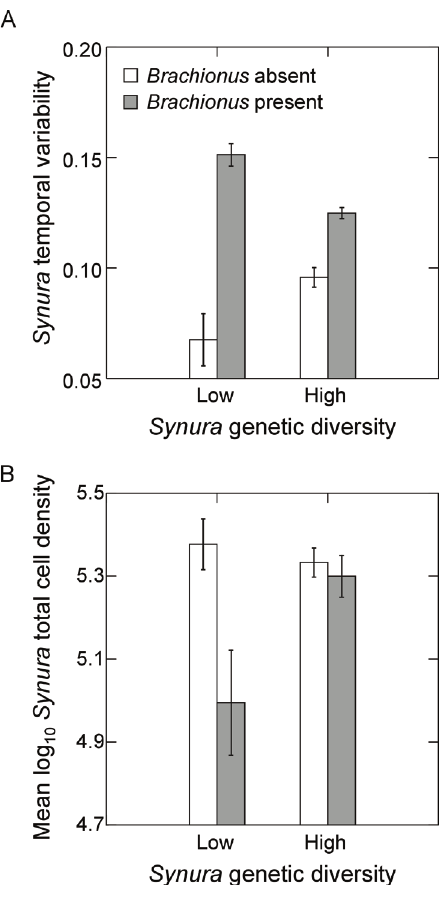
Figure 5. Effects of initial Synura genetic diversity (low versus Figure 6. Effects of initial Synura genetic diversity (low versus high) and Brachionus presence/absence on ( A ) detrended temporal high) and Brachionus presence/absence ( A ) detrended temporal variability of Synura populations (based on total cell densities), variability of free-living cells of Synura , measured as mean residuals measured as mean residuals from linear regressions of log from linear regressions of log transformed free cell densities versus transformed Synura density versus time, and ( B ) Synura total cell time, and ( B ) detrended temporal variability of colony cells of densities averaged over the course of the experiment. Both measures Synura , measured as mean residuals from linear regressions of log ( A and B ) were based on dynamics over days 51 to 167. Shown are transformed colony cell densities versus time. Shown are means means (+/- S.E.). Original units in numbers of individuals per mL. (+/- However, effects of genetic diversity were not strong (main effect: p=0.65, ANOVA; interaction: p=0.10, ANOVA) whereas Brachio- nus significantly increased temporal variability of free-living cells (Figure 6A; F =11.2, p=0.01, ANOVA). Genetic diversity and 1,9 ability of colony cell abundances (Figure 6B; F =39.1, p<0.001, 1,9 presence (p<0.001, max t-test) and absence of Brachionus (p=0.053, max t-test), but effects were stronger when Brachionus was present (Figure 6B).